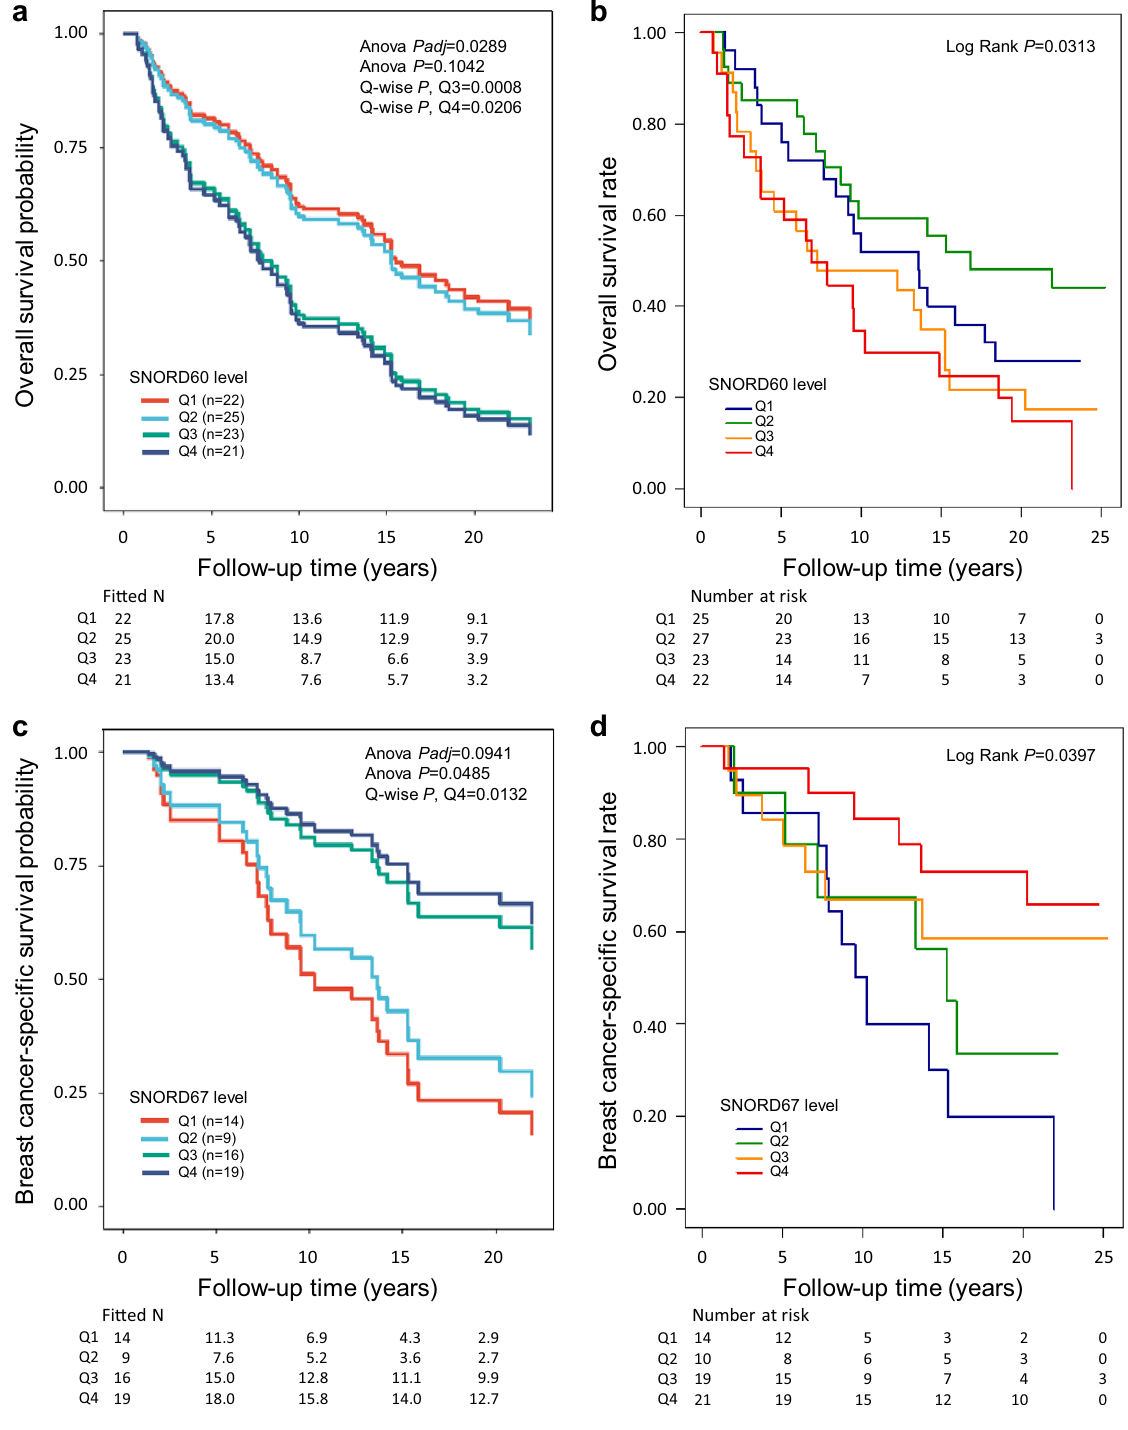
Figure 6. SNORD60 and SNORD67 were identified as candidates for predictive markers for RT in invasive local BC. ( a ) The higher quartiles (Q3 and Q4) of SNORD60 significantly associated with poorer OS in the Cox multivariate analysis including the covariates tumor grade, histology and size, nodal status, ER status, PR status, HER2 status, age at diagnosis, and the treatment parameters CT (yes/no), and adjuvant ET (yes/no) (Overall Padj = 0.1042, Overall P = 0.0289, for Q3 P = 0.0008, HR [CI 95%] = 3.90 [1.76–8.63], and for Q4 P = 0.0206, HR [CI 95%] = 2.48 [1.15–5.37]) in all cases with invasive local BC who had received RT (n = 91). ( b ) Kaplan–Meier plot showing the association of SNORD60 with OS in the univariate analysis (Overall Log Rank P = 0.0313) in all cases with invasive local BC who had received RT (n = 97). ( c ) The highest quartile (Q4) of SNORD67 significantly associated with better BCSS in the cases with ER positive BC (invasive local, n = 58) who had received RT (Overall Padj = 0.0941, Overall P = 0.0485, for Q4 P = 0.0132, HR [CI 95%] = 0.25 [0.08–0.75]; Cox multivariate analysis including the covariates tumor grade, histology and size, nodal status, PR status, HER2 status, age at diagnosis, and the treatment parameters CT (yes/no), and adjuvant ET (yes/no). ( d ) Kaplan–Meier plot showing the association of SNORD67 with BCSS in the univariate analysis (Overall Log Rank P = 0.0397) in cases with invasive local, ER positive BC who had received RT (n = 64). In ( a ) and ( c ), the fitted Ns were extrapolated from the multivariate-fitted survival